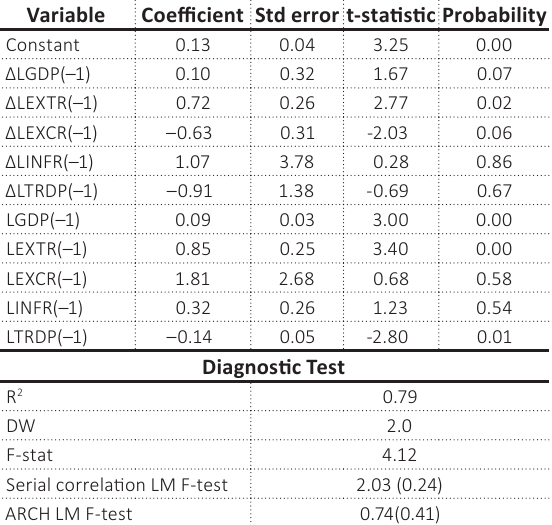
Table 3. ARDL model of estimation